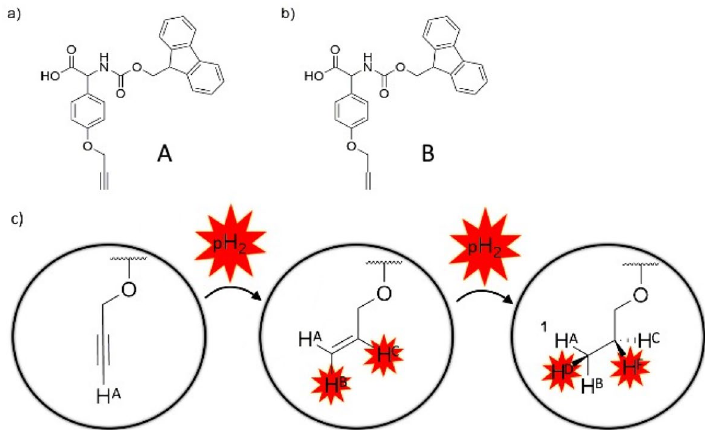
Figure 1. Structures of the incorporated unnatural amino acids used as PHIP markers. (a) Fmoc-l-propargyl tyrosine ( A ) and (b) Fmoc-l-allyl tyrosine ( B ). (c) The propargyl moiety ( A ) is hydrogenated to an allyl moiety ( B ) during the PHIP experiment and then further to a propyl moiety. The cis-orientation of hydrogens in B is supported by the action of a